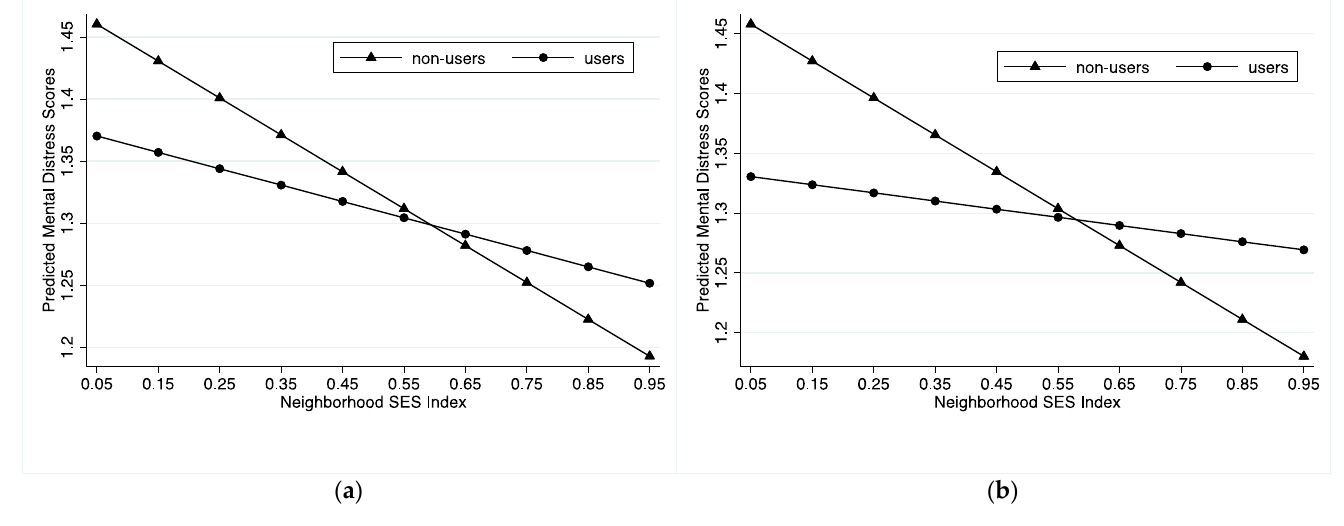
Figure 1. Neighborhood SES and Mental Distress: Internet Use as a Moderator. Table 4. Coefficients of multilevel linear regression of internet use on mental distress among older People use the internet for various purposes, which may lead to different mental adults in Shanghai: SUNS 2016/17: By different purposes of health outcomes. Table 4 shows that when older adults use the internet for social